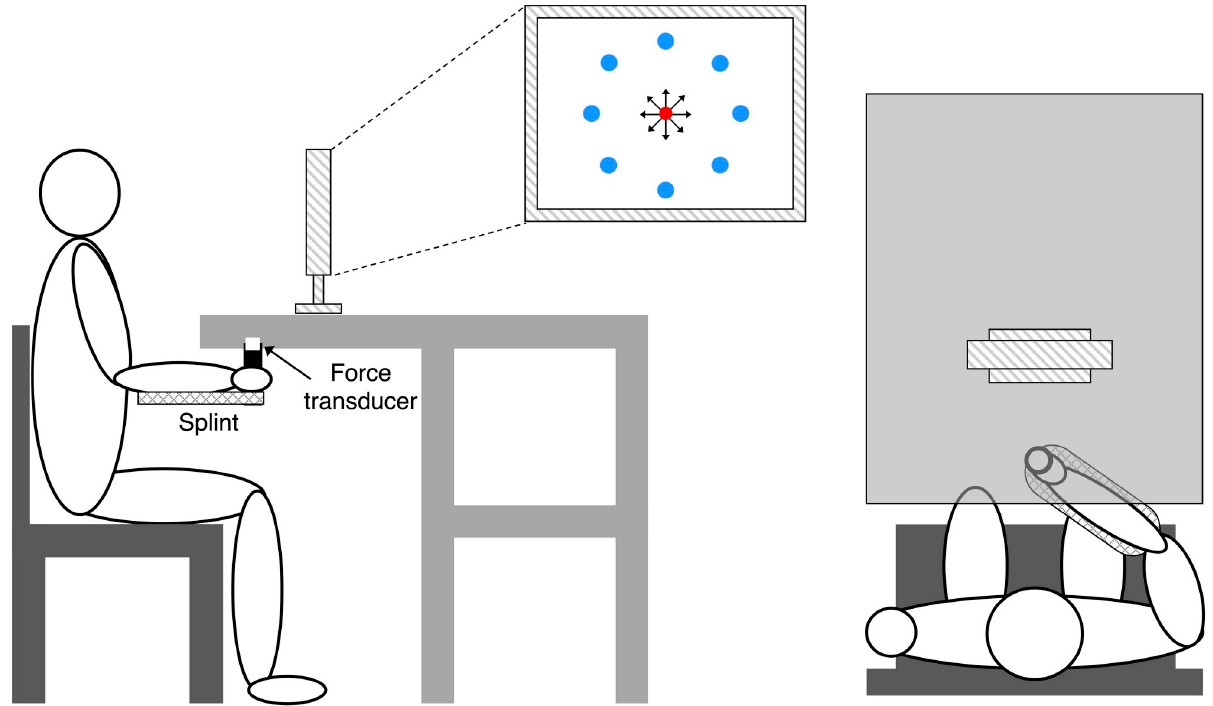
Fig 1. Experimental setup. Participants sat in front of a desktop with their more affected forearm inserted in a splint immobilizing the hand, wrist, and forearm. The center of the palm was aligned with the body midline at the height of the sternum, and the elbow was flexed by approximately 90˚. The participants’ view of their hand was occluded by a table wherein an LCD monitor was positioned about 1 m away. A steel bar at the base of the splint was attached to a force transducer positioned below the table to record isometric forces. Subjects were instructed to perform a goal-directed speed- accuracy aiming task in which they had to maintain the cursor in a central start location (red circle ● ) for 1 s, reach a target as soon as it appeared at one of 8 peripherals targets (blue circles ● ), and maintain the cursor at the target for 0.2 s.